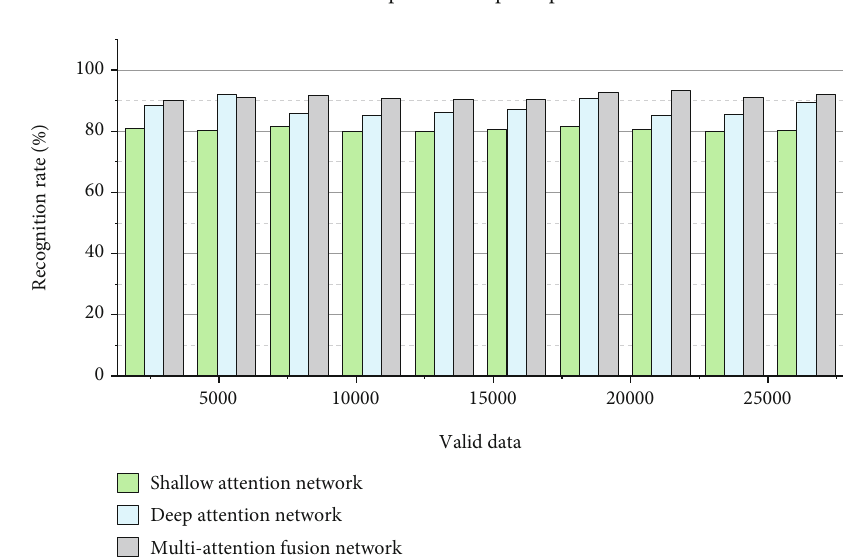
Figure 4: Practical data identi fi ability